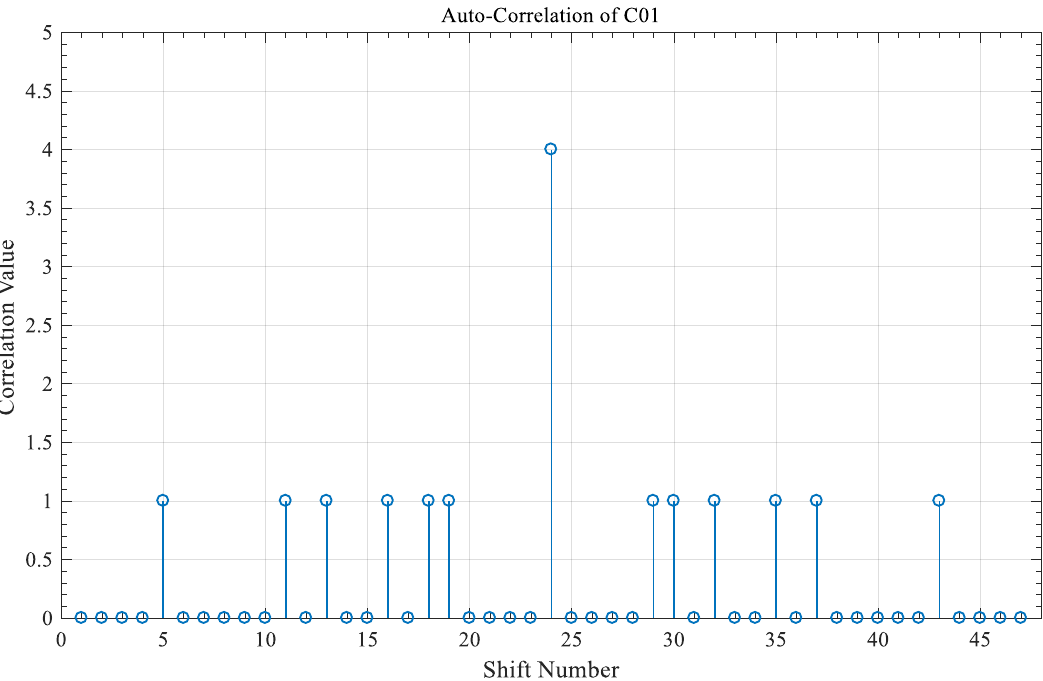
Figure 1. Auto-correlation of 𝐶 01 sequence, 𝑃 1 = 5 and 𝑃 2 = 7.